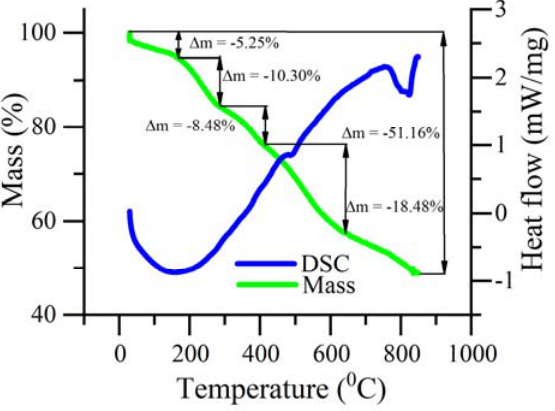
Figure 4. TGA (green line, left axis) and DSC (blue line, right axis) curves of doped polyNiMeOSalen in the temperature range of 20 to 850 °C.